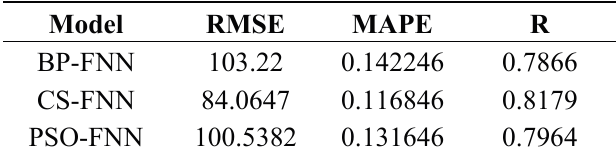
Table 2. Performance statistics of the models on testing dataset in the second scenario.